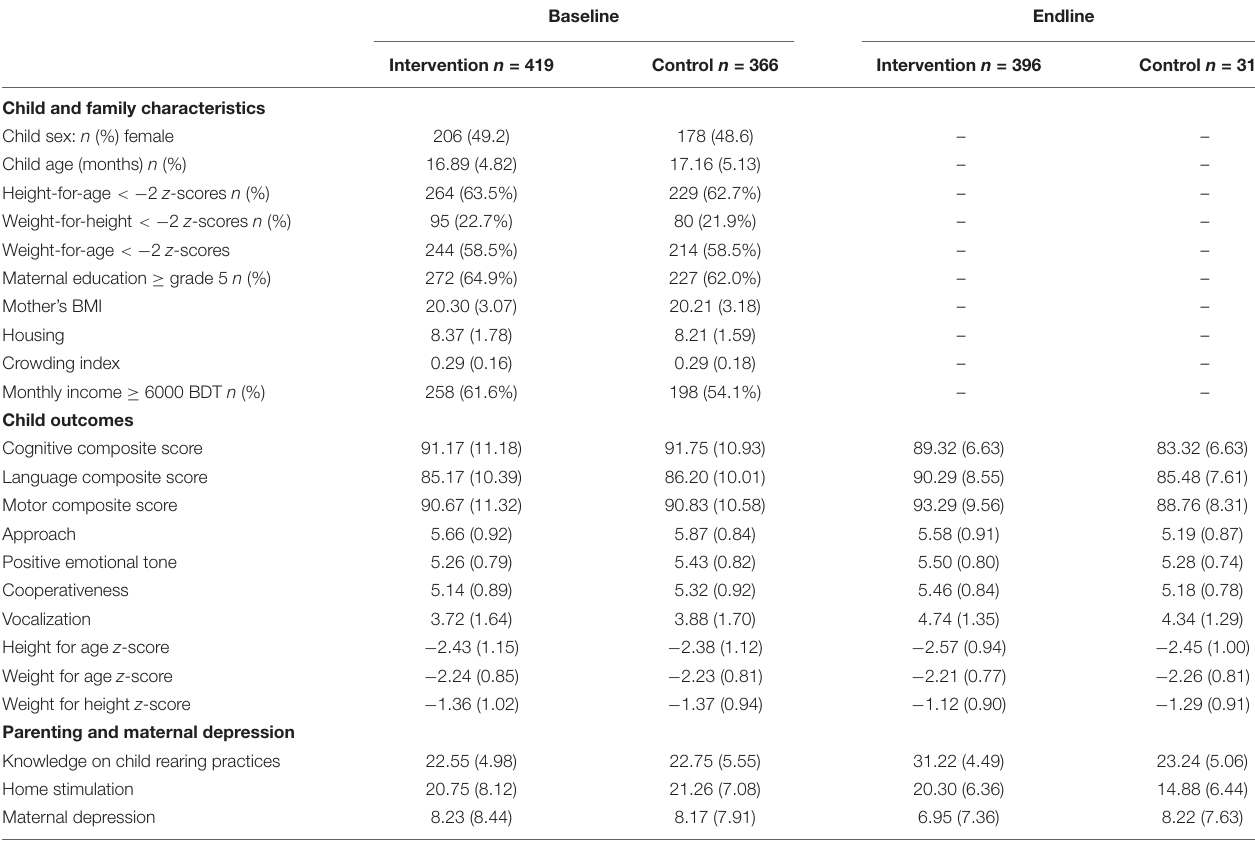
TABLE 1 | Child and family characteristics and child and maternal outcomes at baseline and endline by study